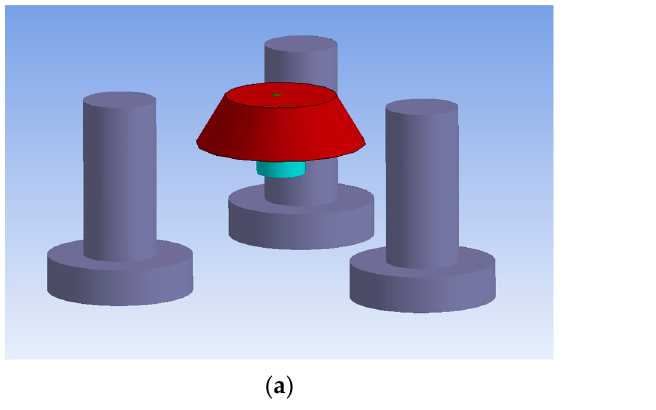
Figure 8. Frequency-domain vs. time-domain verification: ( a ) ANSYS-AQWA time-domain simu- lation; ( b ) Frequency-domain and time-domain power comparison. Table 3. Mooring System Properties [19,20].